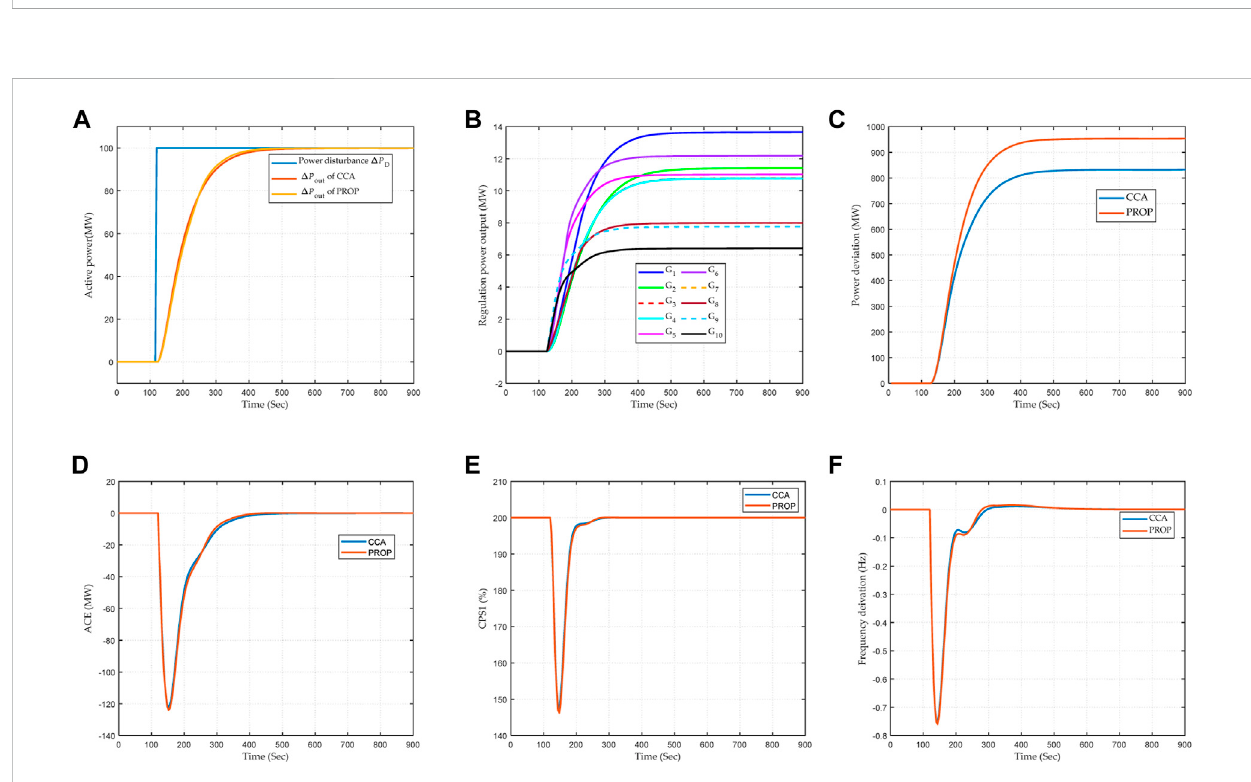
FIGURE 8 Dynamic power tracking schemes acquired by the proposed CCA and PROP at Δ P D (cid:2) 100MW. (A) Power tracking curve. (B) Regulation resource output curves obtained by the proposed CCA. (C) Dynamic power deviation. (D) Dynamic ACE. (E) Dynamic CPS. (F) Dynamic frequency deviation.